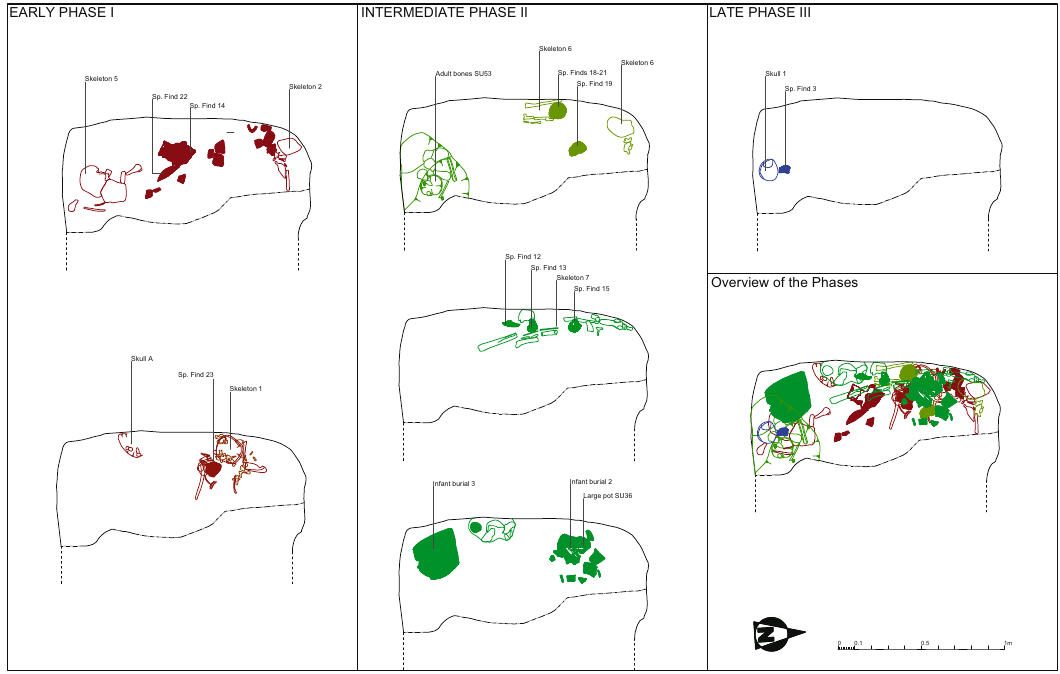
Figure 3: Plans of phases and